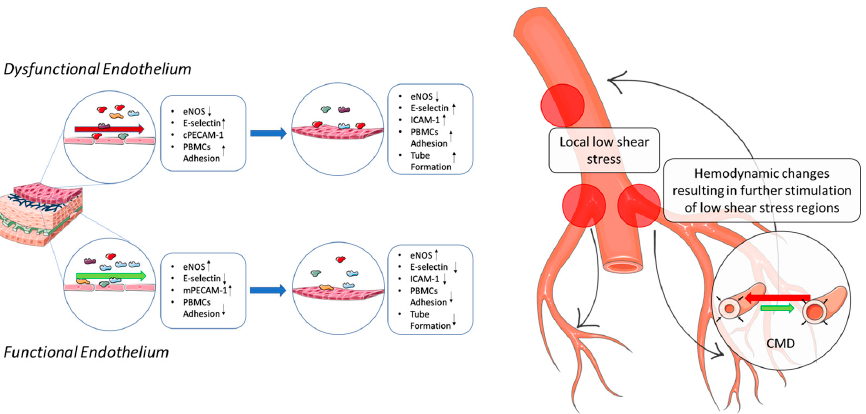
Figure 16. Schematic representation of the results obtained. Endothelial cells (ECs) exposed to LSS are characterized by decreased eNOS levels, an increase in adhesion molecules and the cytoplas- matic localization of PECAM-1 (cPECAM-1), while ECs challenged with HSS display high eNOS level and limited expression of adhesion molecules and PECAM expression at adherens junctions (mPECAM-1). Tube formation is significantly increased in ECs cultured in LSS-CM demonstrating the presence of angiogenic factors in the conditioned media. The image on the right represents a proposed mechanism correlating coronary microvascular dysfunction (CMD) to epicardial coronary artery disease (CAD) associated with low shear stress regions. Coronary arteries are rich in regions experiencing low shear stress during the cardiac cycle, which are often inner curvatures or bifurca- tions. ECs at these regions are then exposed to low shear forces for a prolonged period before ath- erogenesis. During this period, it is possible that ECs could release various factors affecting nearby cells as well as downstream microvascular endothelial cells ultimately promoting CMD. In fact, CMD was found to precede in time epicardial CAD, and this is likely to be related to hemodynamic changes in the microvascular compartment affecting upstream blood flow (smart.servier.com). Author Contributions: Conceptualization, F.B. (Fabio Bertani) and F.B. (Francesca Boccafoschi); methodology, F.B. (Fabio Bertani) and M.D.C.; software, F.B. (Fabio Bertani); validation, F.B. (Fabio Bertani), F.B. (Francesca Boccafoschi) and M.D.C.; formal analysis, F.B. (Fabio Bertani) and M.D.C.; investigation, F.B. (Fabio Bertani) and M.D.C.; resources, F.B. (Francesca Boccafoschi), L.G.F. and M.T.; data curation, F.B. (Fabio Bertani) and M.D.C.; writing—original draft preparation, F.B. (Fabio Bertani); writing—review and editing, F.B. (Francesca Boccafoschi), D.D.F. and L.G.F.; visualization, F.B. (Fabio Bertani); supervision, F.B. (Francesca Boccafoschi); project administration, F.B. (Fran- cesca Boccafoschi); funding acquisition, F.B. (Francesca Boccafoschi). All authors have read and agreed to the published version of the manuscript Funding: This research received no external funding Conflicts of Interest: The authors declare no conflict of interest. Abbreviations CVD